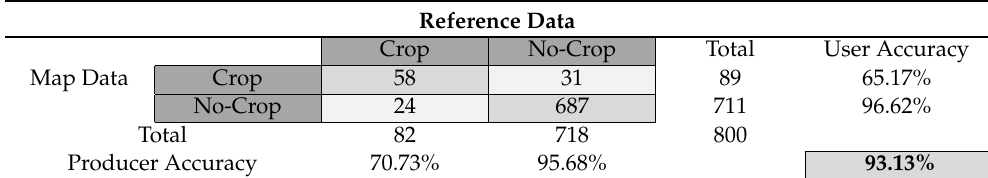
Table 8. The error matrix generated using balanced reference samples generated in crop buffer zone